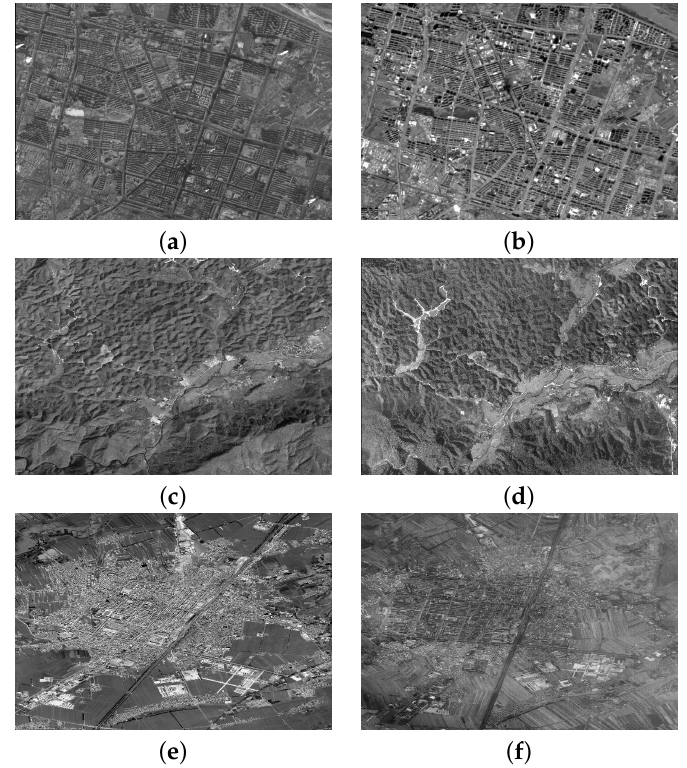
Figure 1. Examples of multi-source satellite images for image matching: ( a ) nadir-viewing image of the ZY-3 satellite; ( b ) forward-viewing image of Mapping Satellite-1; ( c ) backward-viewing image of the ZY-3 satellite; ( d ) panchromatic image of the SPOT-5 satellite; ( e ) Google Earth image under the geographic coordinate system; ( f ) nadir-viewing image of Mapping